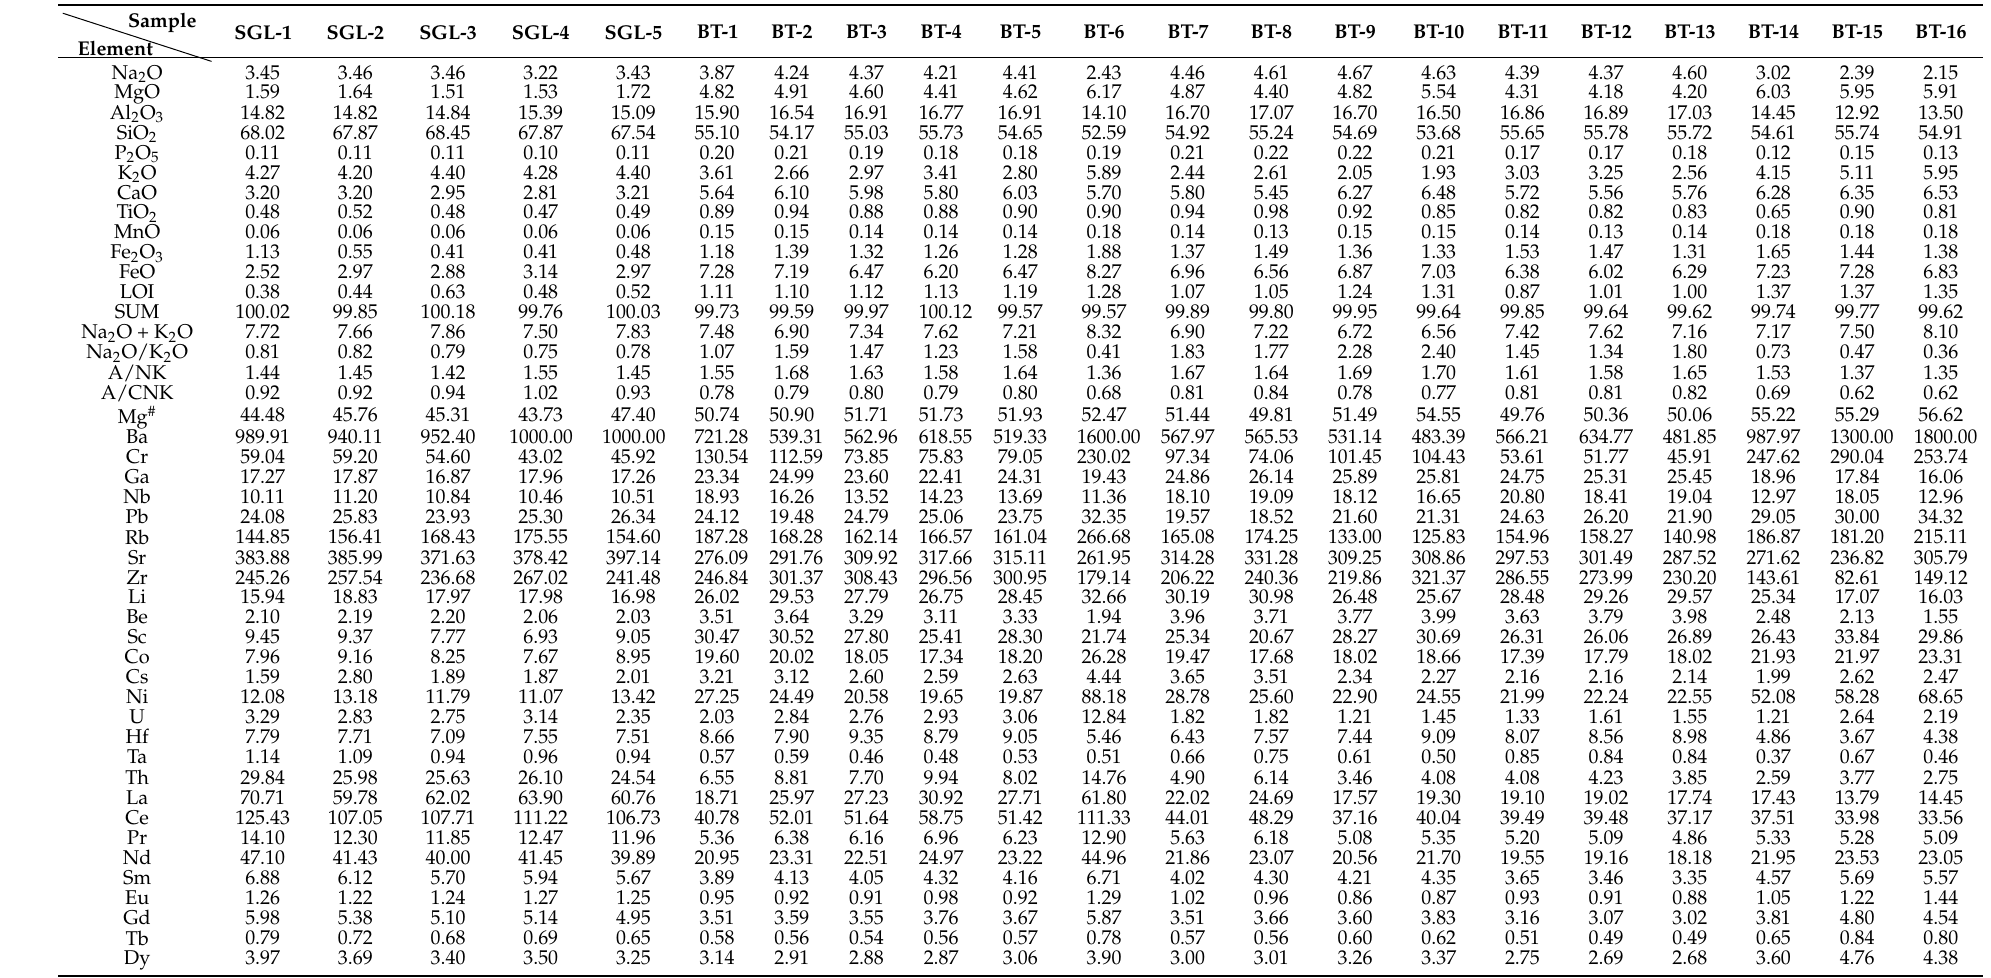
Table 4. Major (wt.%) and trace element (ppm) geochemical data for the host Sanguliu granodiorite and monzodiorite